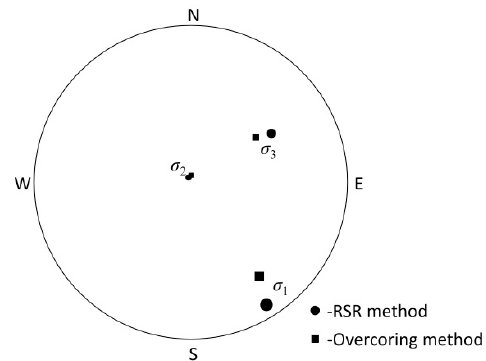
Figure 16. Comparison of principal stress components from the RSR and overcoring methods in the PDS No. 1 coal mine.